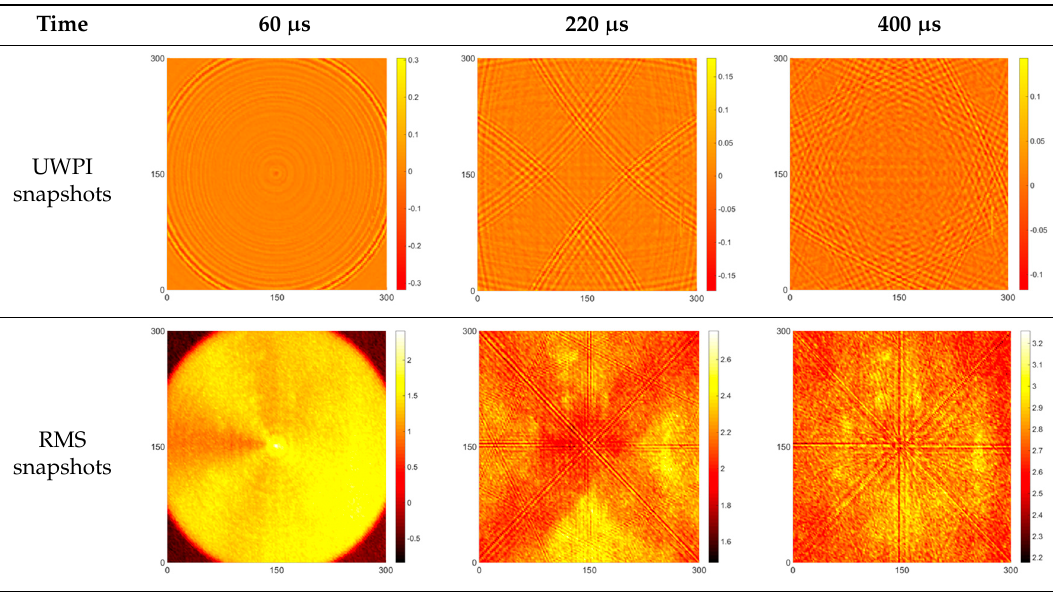
Table 1. UWPI and RMS snapshots of the intact specimen at 60 μ s, 220 μ s and 400 μ s (the unit of x and y axis: mm).